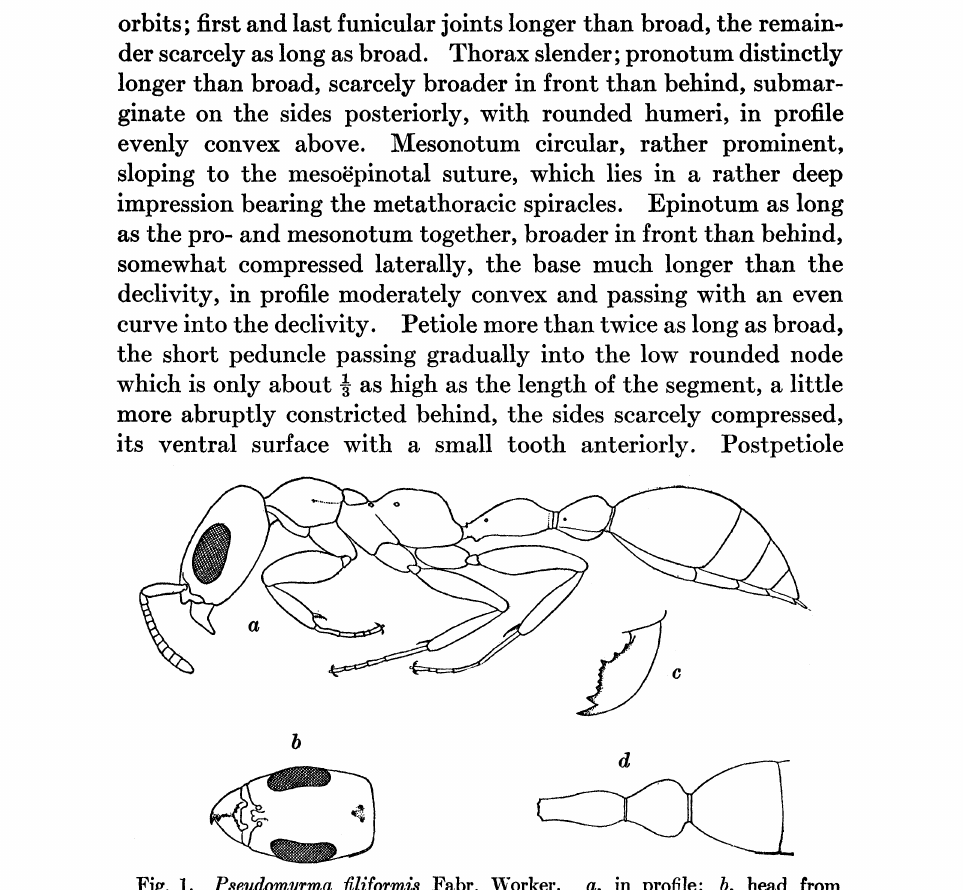
Fig. 1. Pseudorayrma filiformis Fabr. Worker. a, in profile; b, head from above; c, mandible; d, petiole, postpetiole and first gastric segment from above. twice as broad as the petiole and about as broad as long, narrowed in front, subtriangular from above and